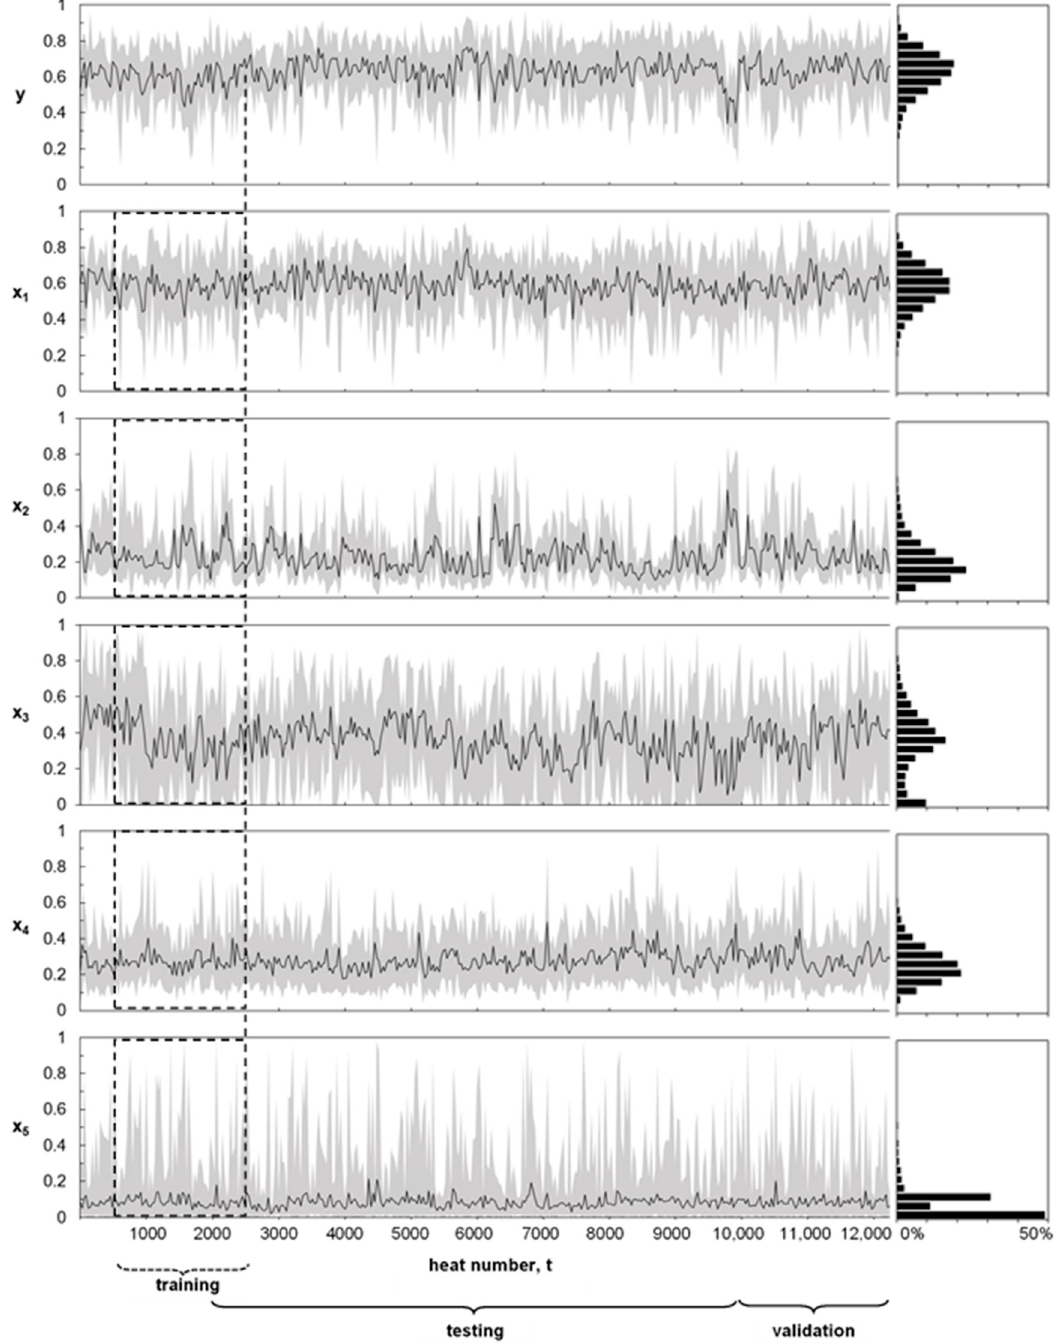
Figure 2. Time evolution and histograms corresponding to the six involved variables. The dataset contains 12,195 registers covering one full production year. The first 10,000 heats were used for training and testing while the last 2195 were reserved for final validation. The minimum–maximum interval (gray area) and the average value (solid line) for groups of 30 heats are shown for clarity. The dashed boxes illustrate a moving training window of width w = 2000 for heat number t = 2500.